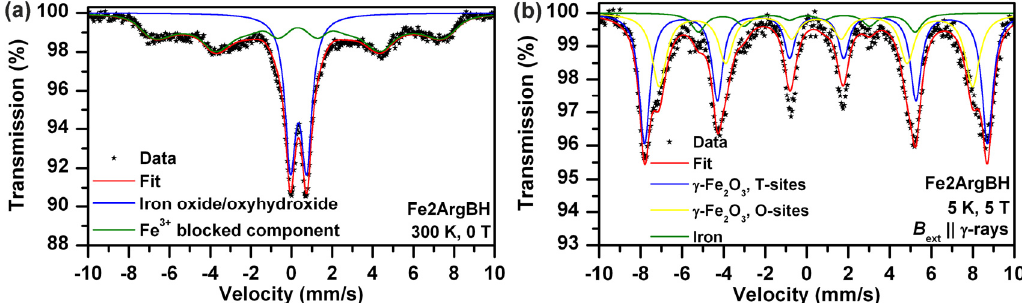
Figure 1. ( a ) Mössbauer spectrum of Fe2ArgBH recorded at room temperature; ( b ) Mössbauer spectrum of Fe2ArgBH recorded at 5 K; ( c ) Mössbauer spectrum of Fe2GluBH recorded at room